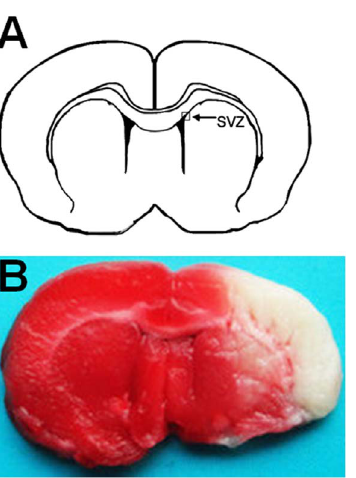
Figure 2. Infarct volume assessed by TTC staining 1 day after the tMCAO. (A) Position of SVZ in the coronal section of brain. Areas imaged for immunofluorescence studies are indicated by box. (B) Coronal brain section stained by TTC 1 day after tMCAO. The white areas without deep red-staining indicate ischemic areas. SVZ, subven- tricular zone.